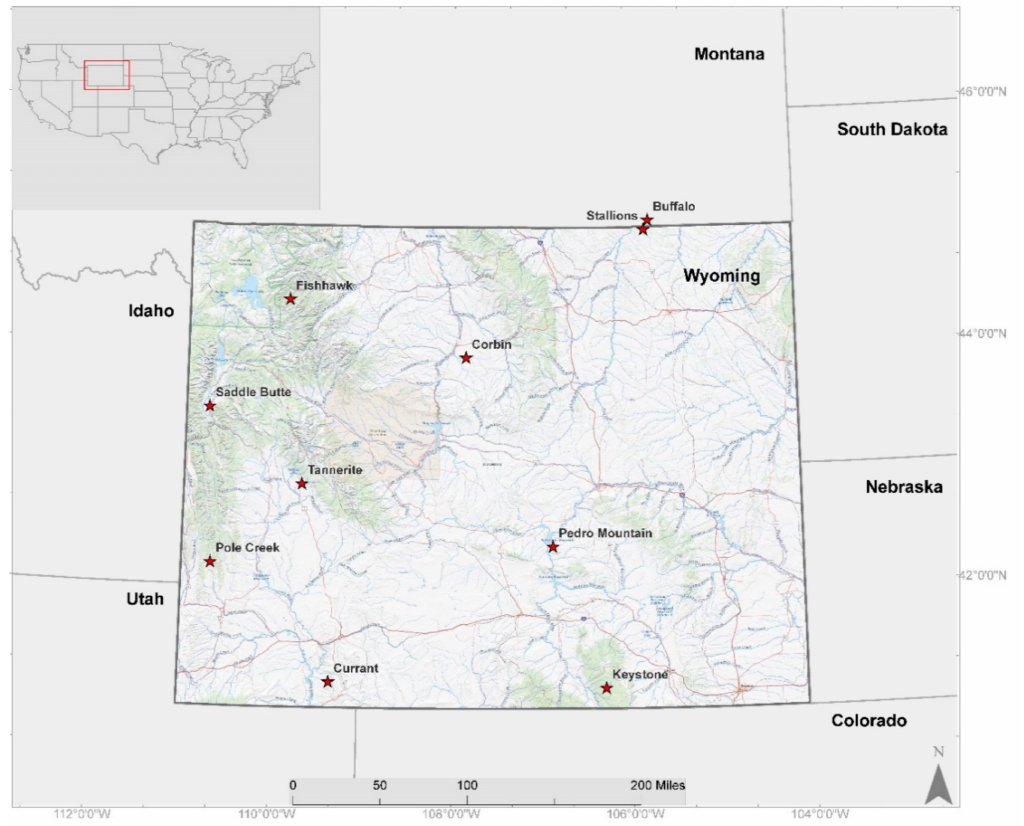
Figure 1. Distribution of 2017 and 2019 Wyoming and Montana fire events used in this